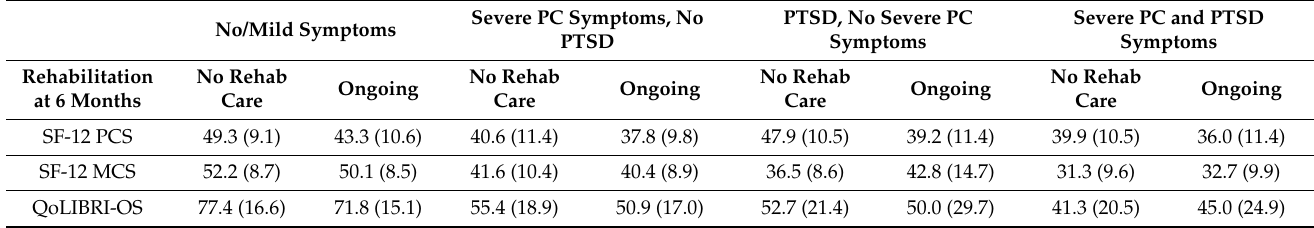
Table A3. HRQoL for patients who had ongoing rehabilitation care or not at 6 months.